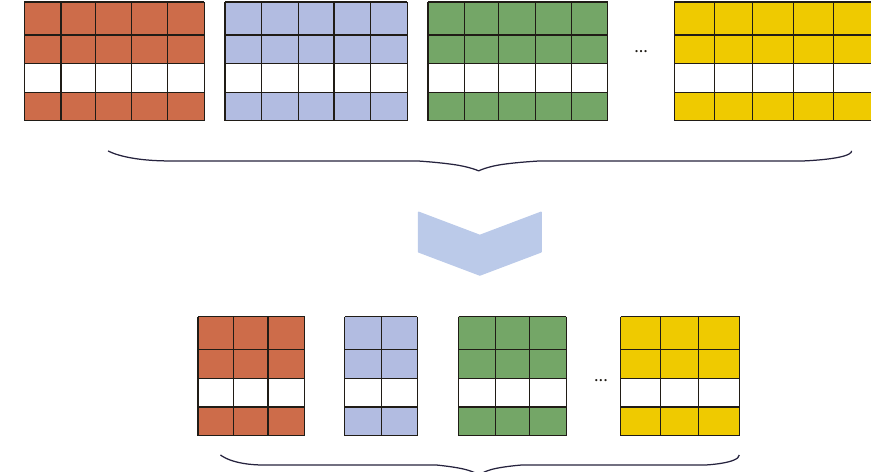
Figure 7: Augmented matrix variable selection.